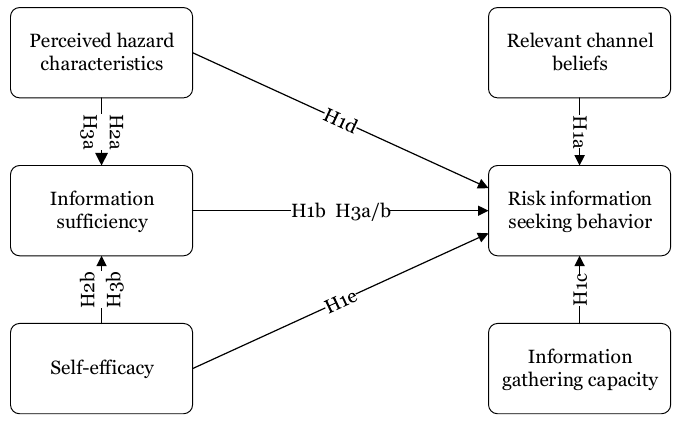
Figure 2. Hypotheses of risk information seeking behavior.